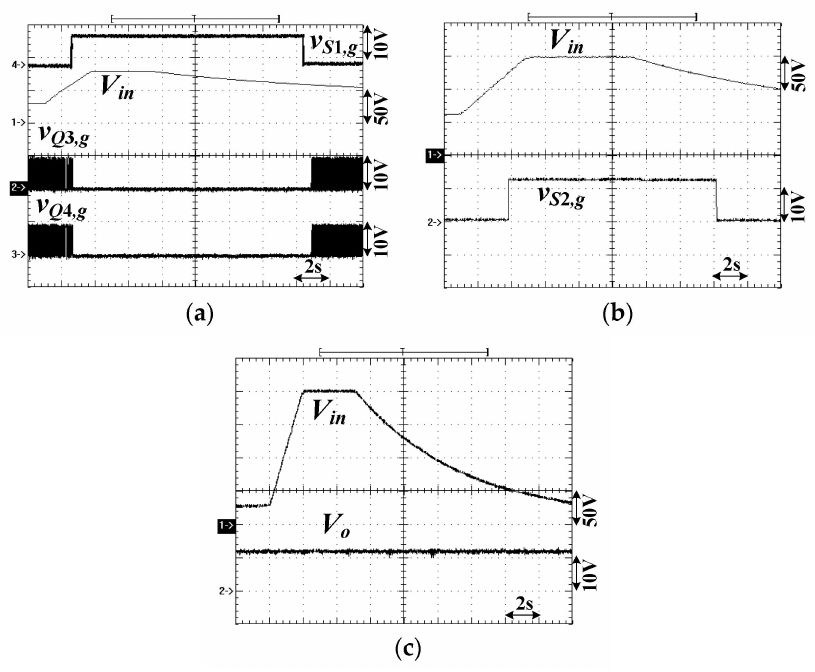
Figure 14. Measured waveforms under full load ( a ) V in , v S 1 ,g , v Q 3 ,g , v Q 4 ,g , ( b ) V in , v S 2 ,g , and ( c ) V in , V o